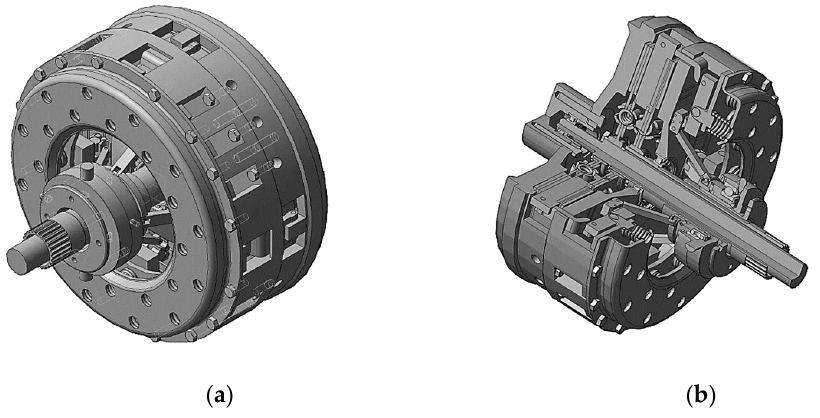
Figure 1. 3D model of the DCT: ( a )—general view; ( b )—cross-sectional view.